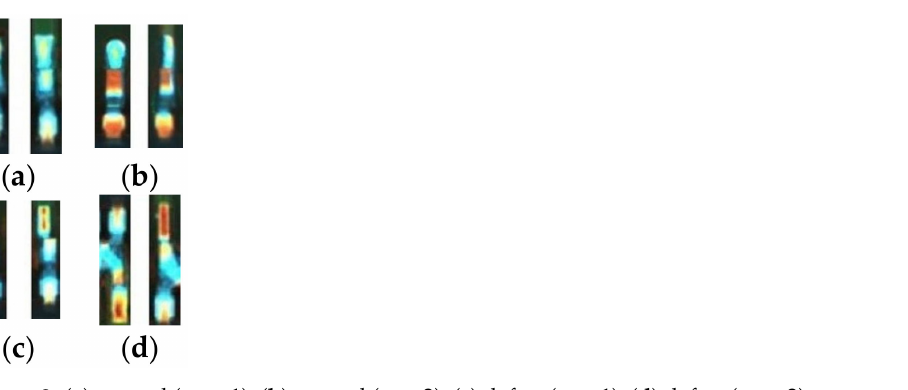
Figure 2. ( a ) normal (type 1); ( b ) normal (type2); ( c ) defect (type1); ( d ) defect (type 2).